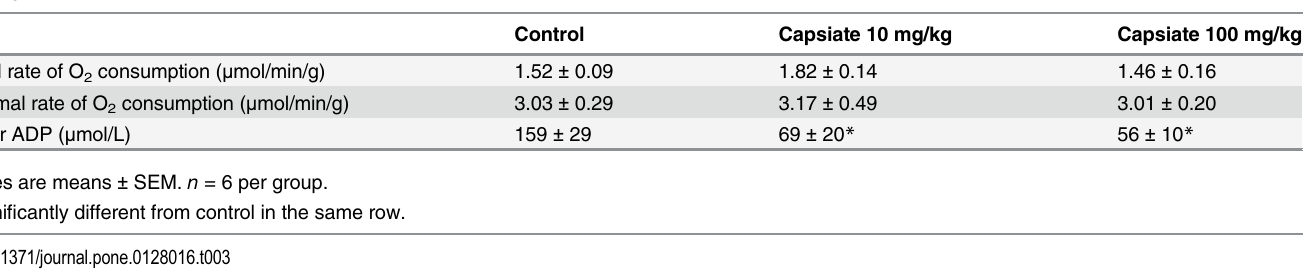
Table 3. Effect of 2-week daily administration of vehicle or capsiate on respiration parameters in isolated permeabilized fibers from gastrocnemius muscle.